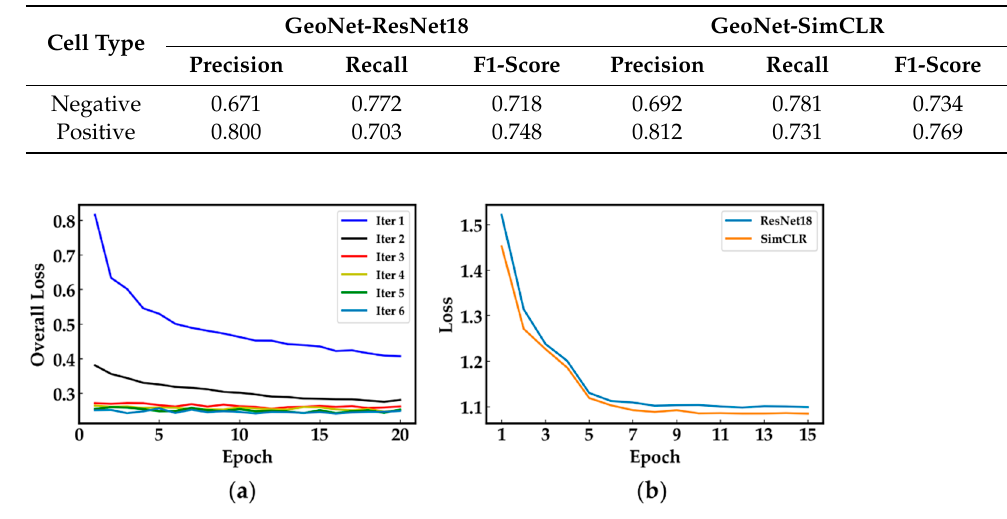
Figure 11. ( a ) Localization loss curves and ( b ) classification loss curves of GeoNet for PanNuke.